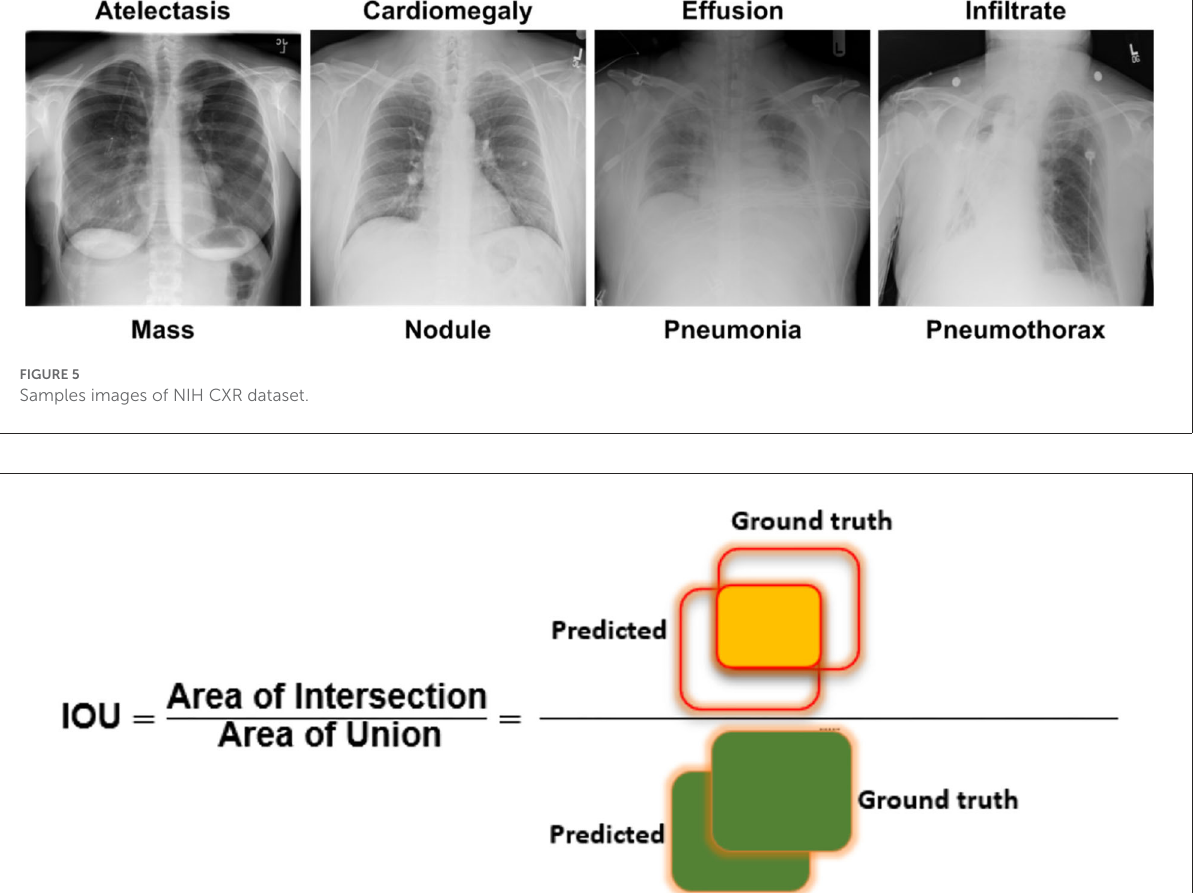
FIGURE6 Visual depiction of IOU